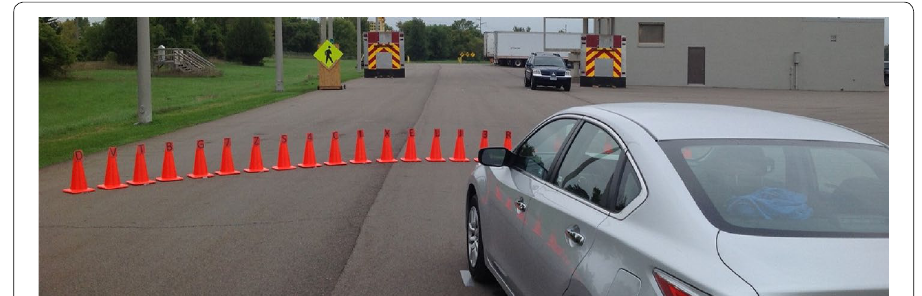
Fig. 3 Experimental set-up of study 2. Trims were presented at two angle locations, 60.19 or 77.38° from the left most cone at a distance of 30 m. Mock firetruck rear ends were located behind the trims at 54.45° and at 71.65° from the left most cone. A road sign was located at 48.72°, and an SUV at 65.92° from the left most